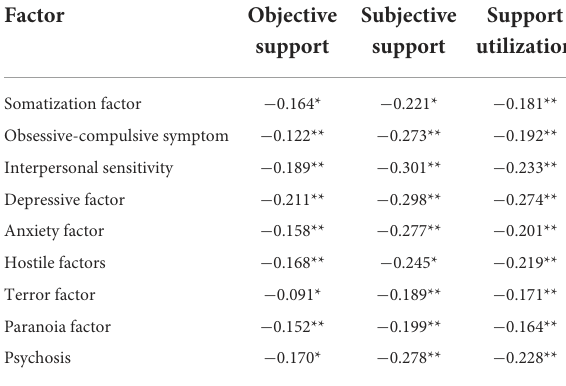
TABLE 3 Positive detection rates of SCL-90 factors among poor and non-poor students.